Question: Write a single sentence explaining what this figure depicts.
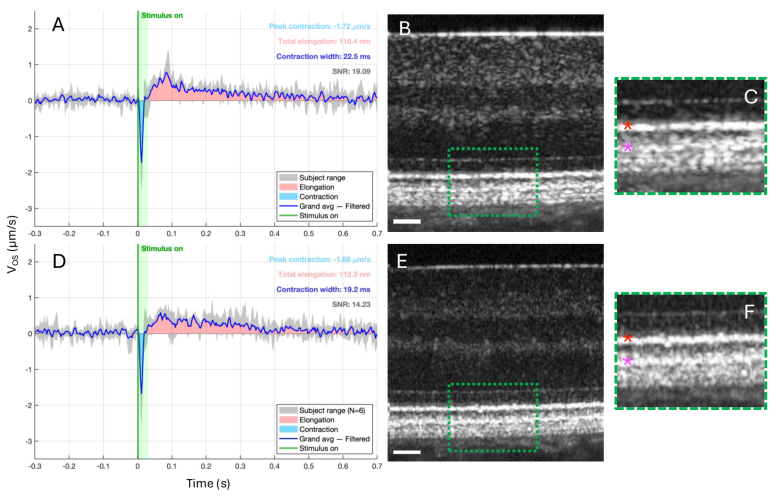
Answer: Impact of lateral resolution on ORG near the fovea. Mean ORG traces across seven eyes for low-NA (A) and high-NA (D) imaging acquired 2° temporal to the fovea. (B,E) Representative averaged B-scans from one subject at low and high NA respectively, and corresponding magnified views of the outer retinal bands are shown in (C,F). Red and magenta stars indicate the ISOS and COST layers, respectively. Scale bar = 50 µm.